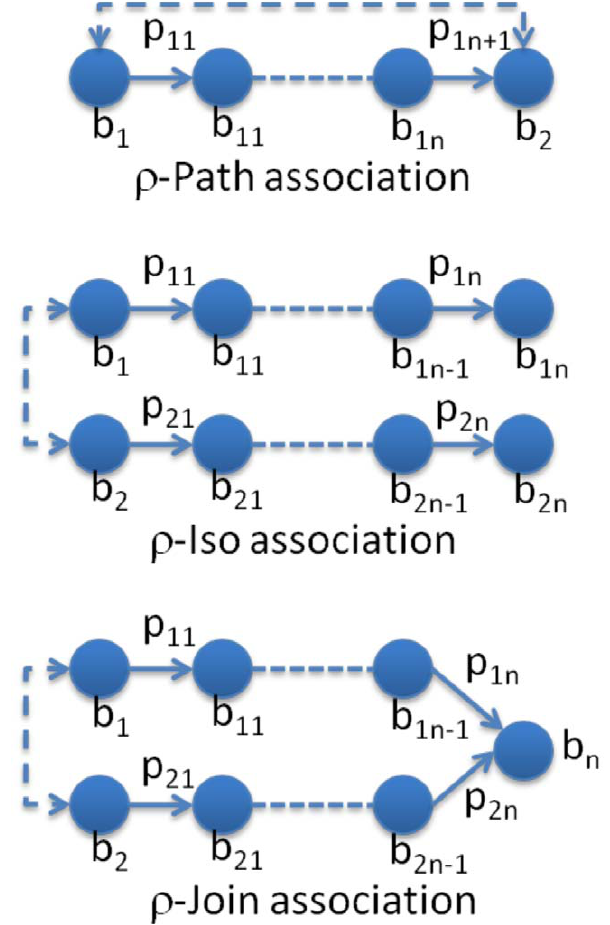
Figure 3. Semantic Association.